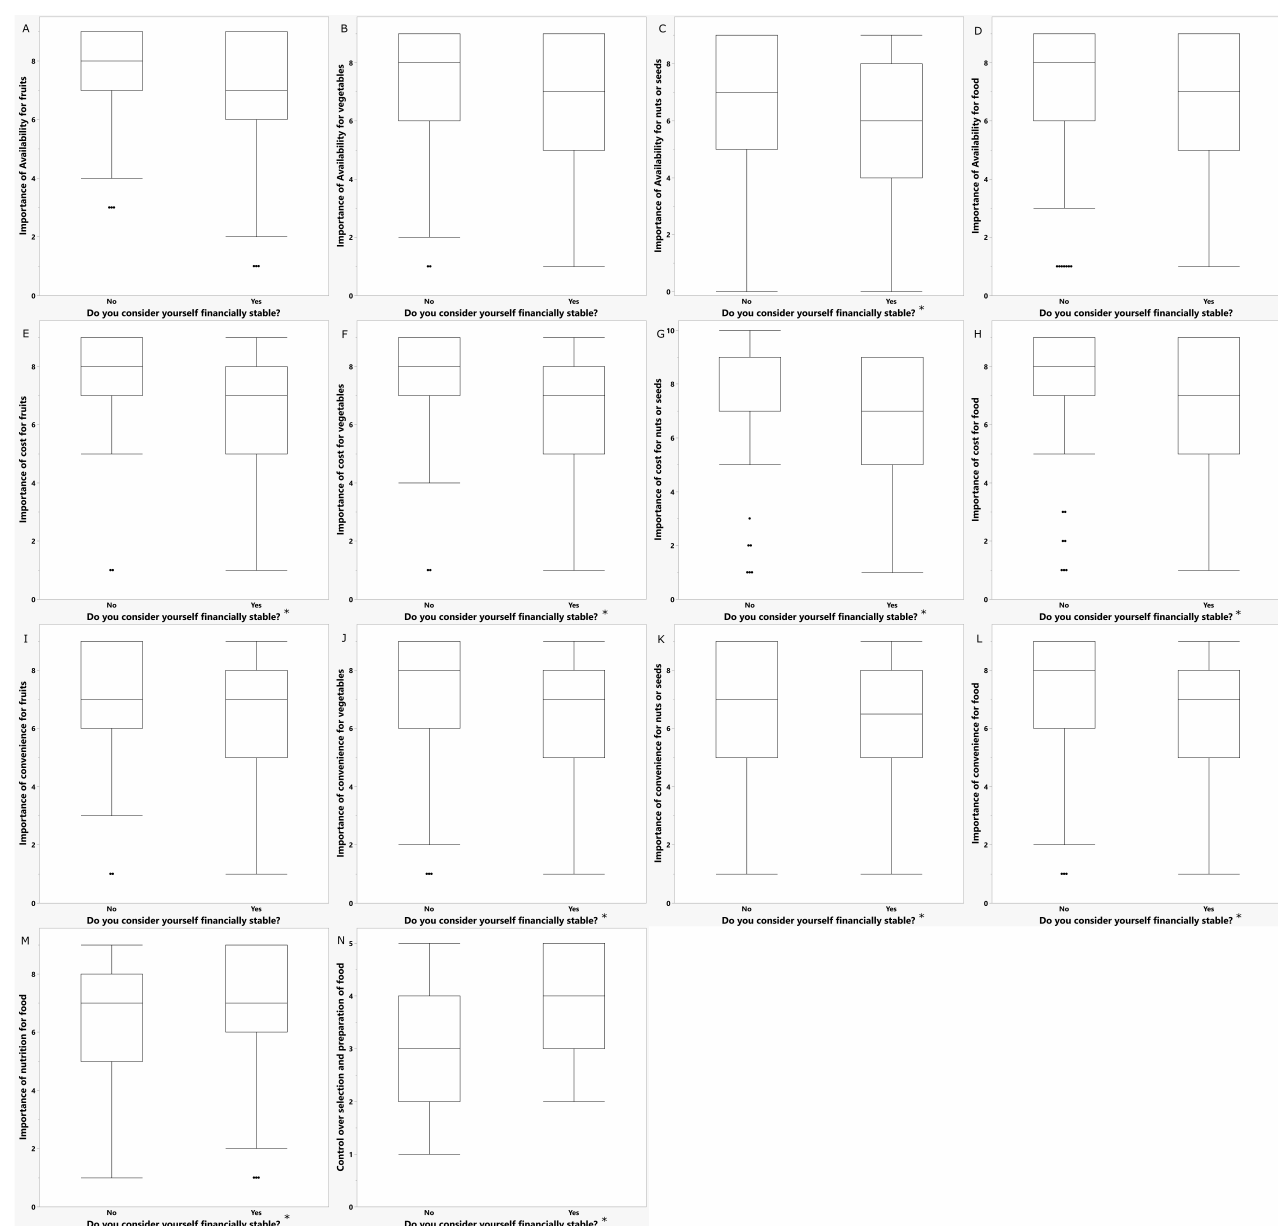
Figure 1. Ratings of importance of factors for food consumption by perception of financial